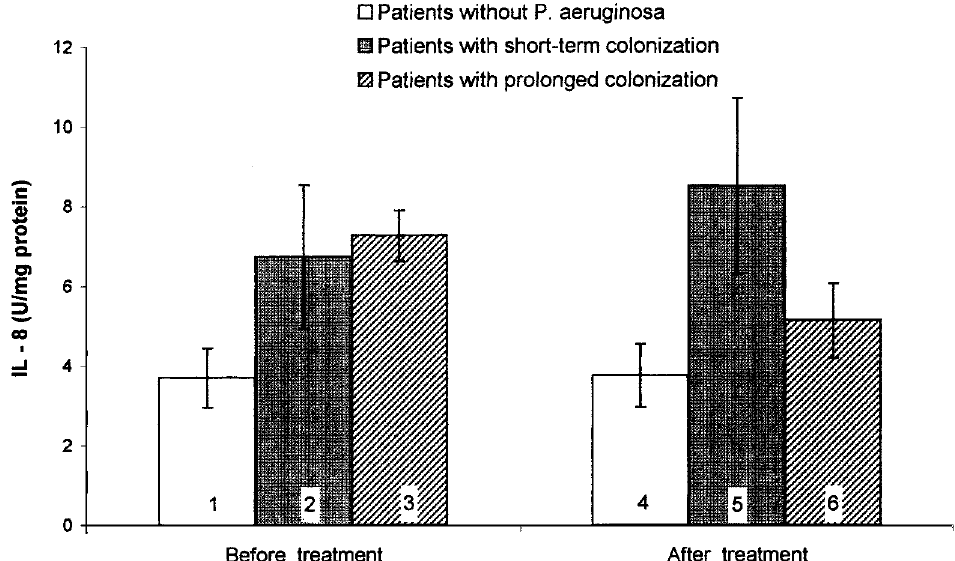
FIG. 3. IL-8 concentrations in the sputum of CF patients during exacerbation treatment. Sputum samples were obtained from CF patients before and after antibiotic treatment and assessed for IL-8 content by ELISA. Values were normalized to sputum protein concentrations and represent the average ± standard deviation. An umpaired, two-tailed Student’s t -test ( p 1,3 = 0.02; p 4,6 =